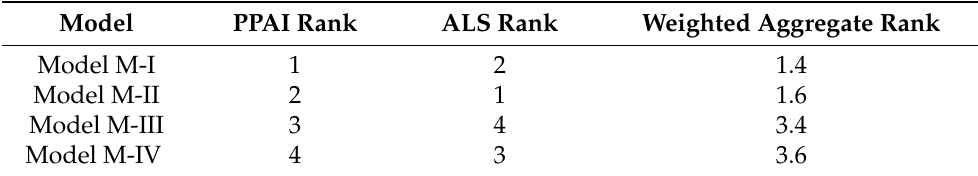
Table 6. Hypothetical model ranks according to PPAI and